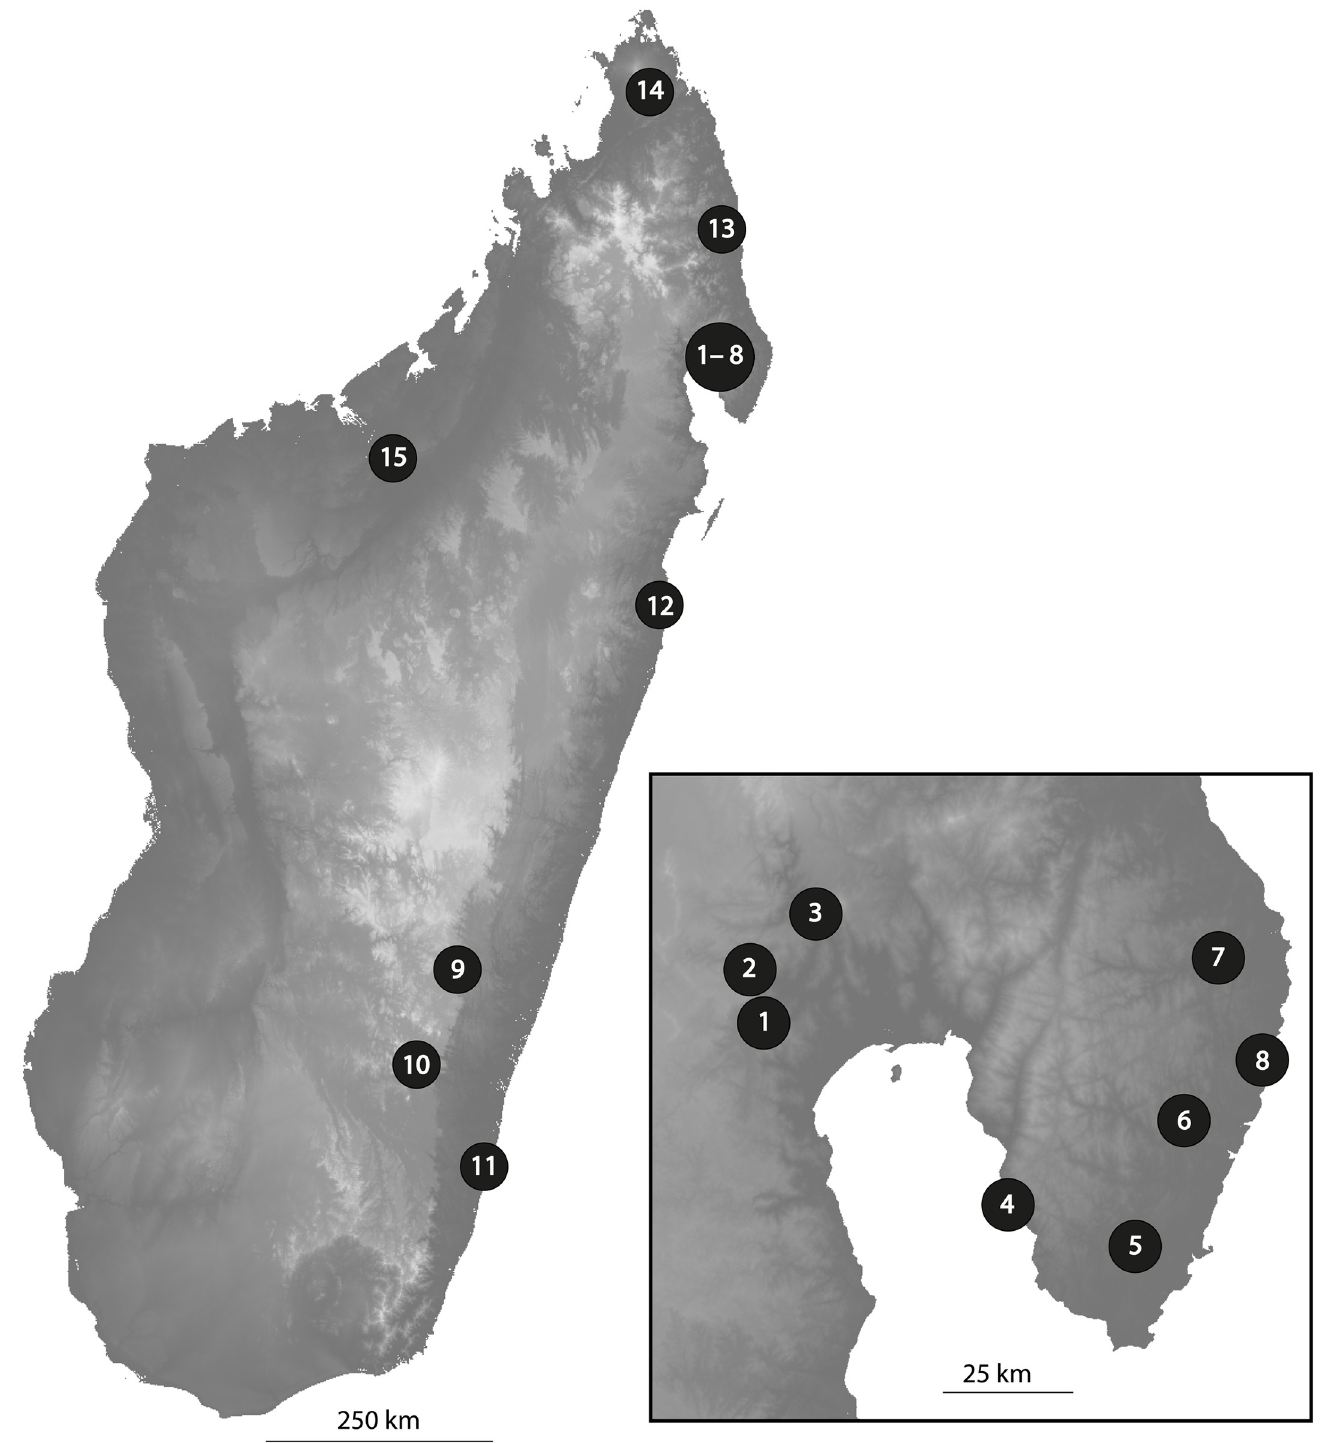
Fig 1. Map of Madagascar illustrating the geographic positions of sampling sites. The inset in the bottom right corner shows the Bay of Antongil. Gray scale values denote elevation, with lighter color indicating higher elevations. More detailed information about sampling locations is given in Table